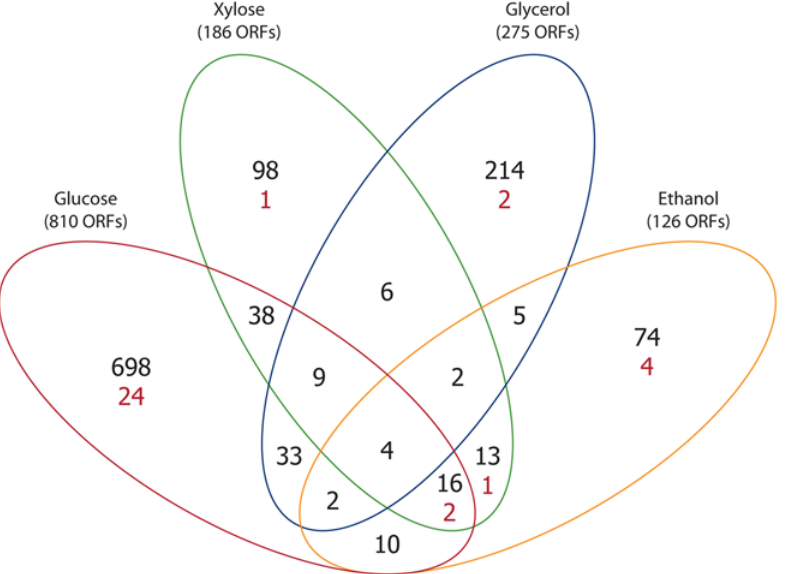
Figure 2. Venn diagram of genes with significant differential regulation in comparison of growth of A. nidulans A4 and phosphoketolase (PHK) over-expressing A. nidulans AR1 phk GP74 on four different carbon sources. The over-expressed phosphoketolase, and argB, the transformation marker, are considered to be artefacts and were removed from the central group. Black numbers are the number of differentially regulated genes within each subgroup. Red numbers (below if present) are the number of putative transcription factors identified in that group.